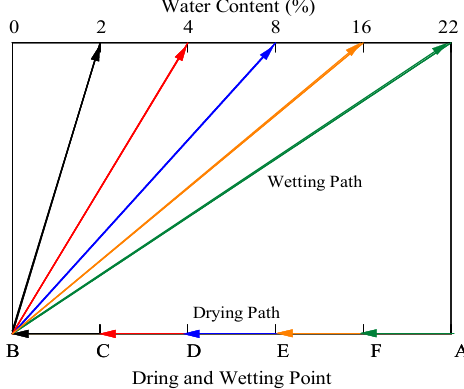
Figure 6. Drying and wetting paths.